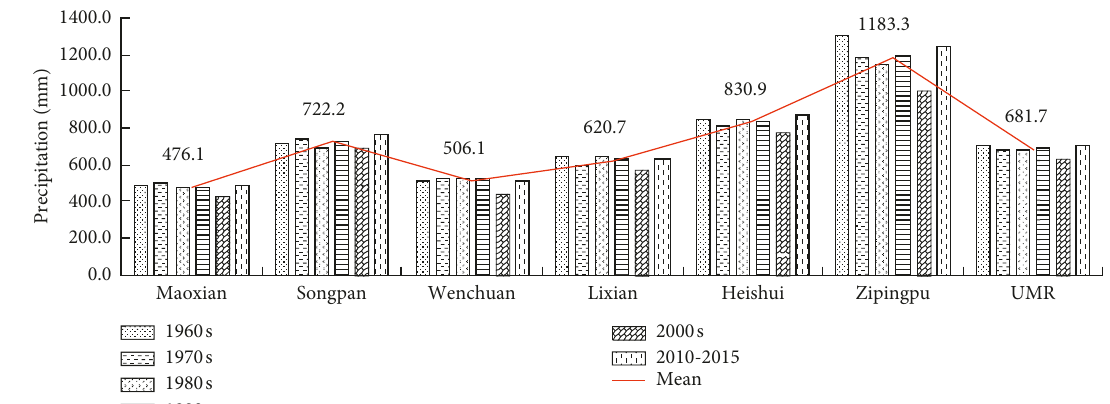
Figure 4: Variation of decade mean annual precipitation in gauging stations and